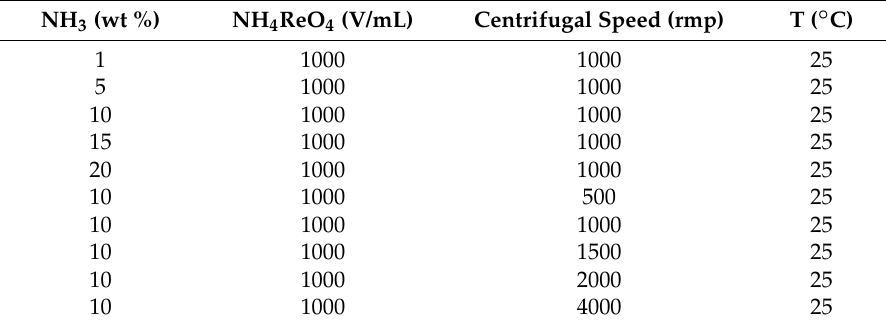
Table 1. Experimental parameters at different experimental conditions.